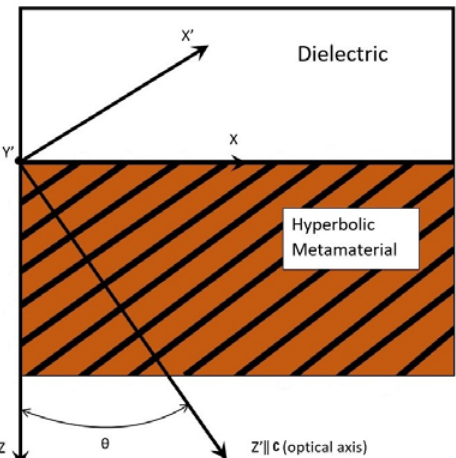
Figure 1: Schematic view of the hyperbolic metamaterial slab bordered with the dielectric. The Z ′ axis is parallel to the c